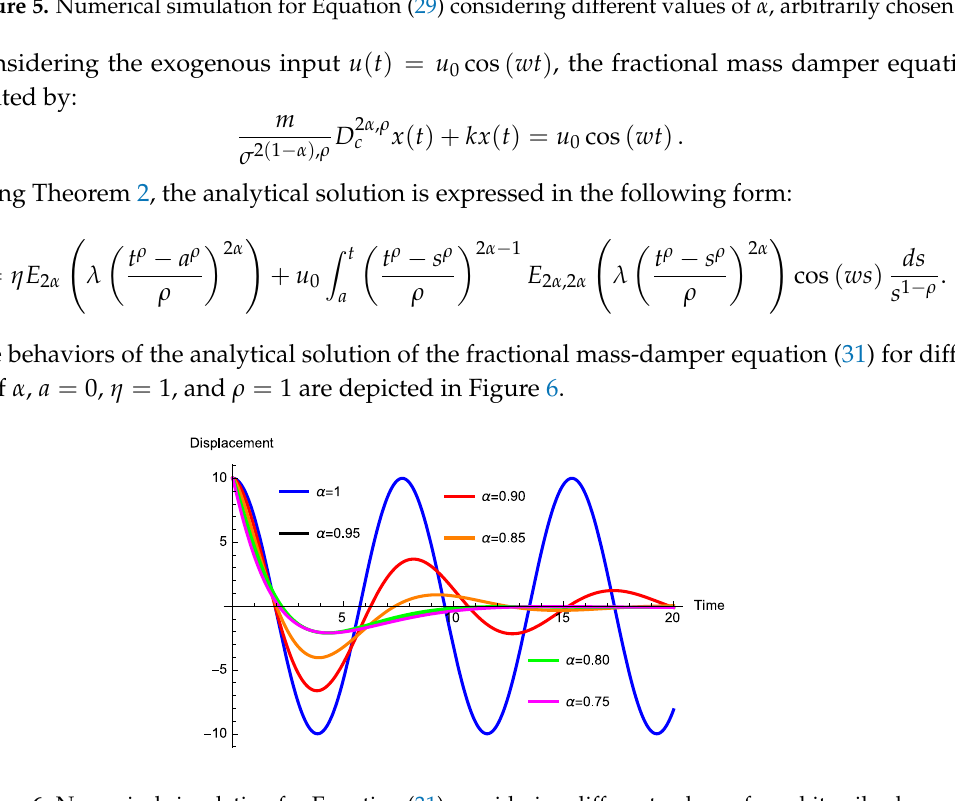
Figure 6. Numerical simulation for Equation (31) considering different values of α , arbitrarily